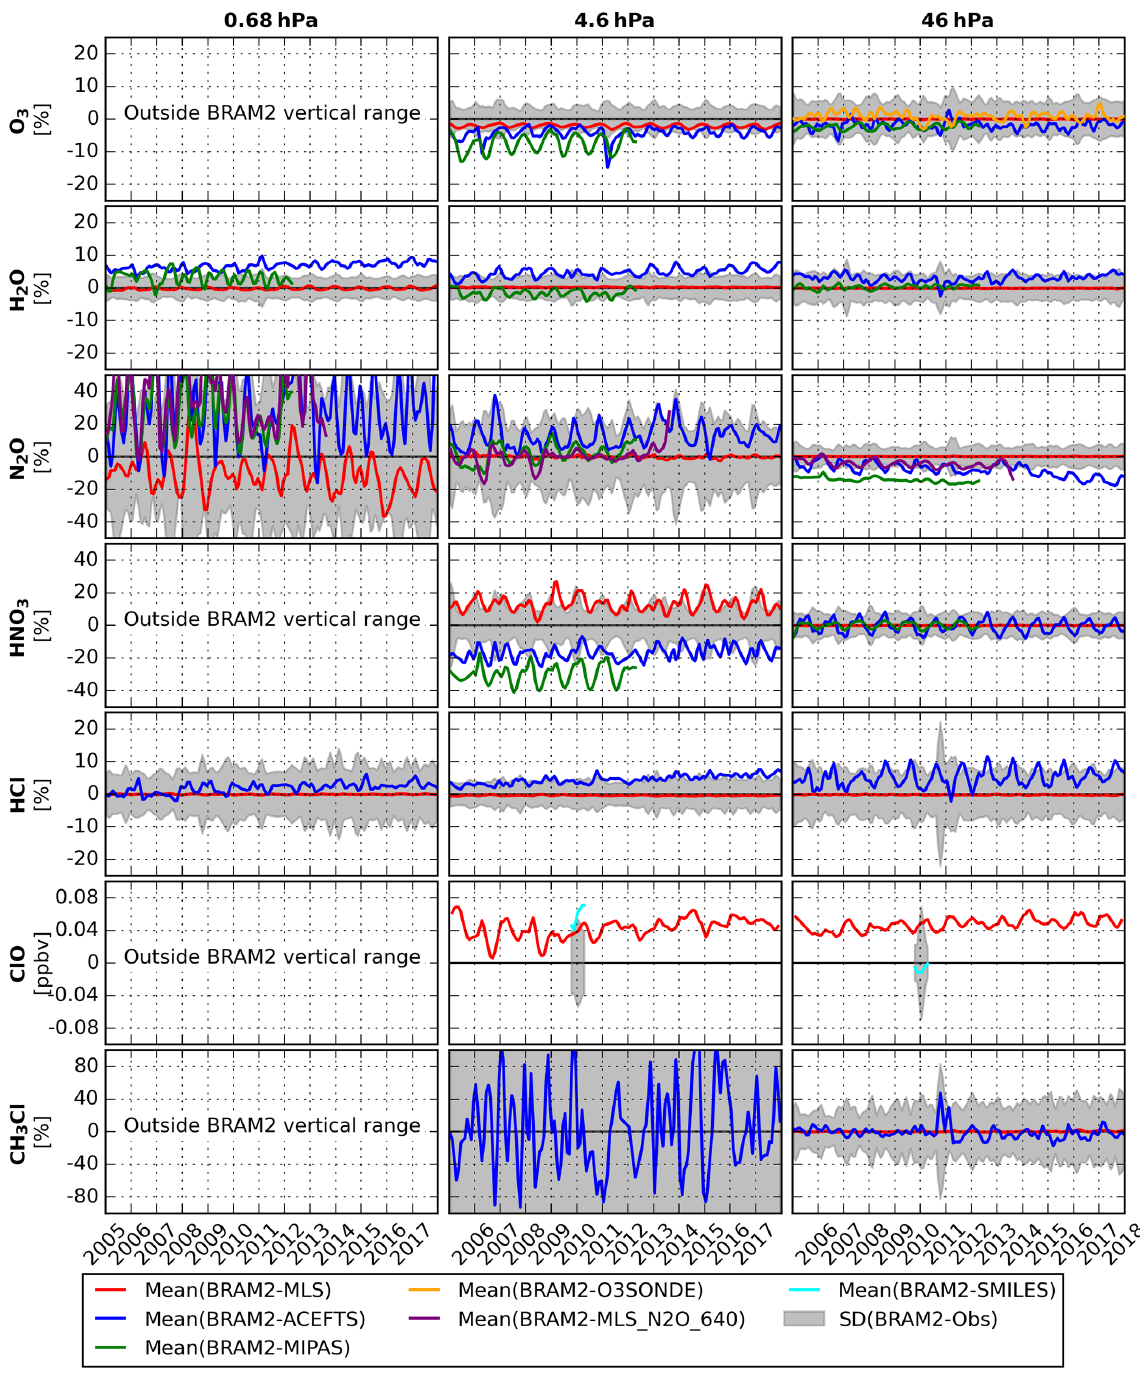
Figure 6. Time series of the monthly mean differences between BRAM2 and the different observational datasets in the Northern Hemisphere mid-latitudes (30–60 ◦ N) at three pressure levels (from left to right: 0.68, 4.6 and 46hPa) and for (top to bottom) O 3 , H 2 O, N 2 O, HNO 3 , HCl, daytime ClO and CH 3 Cl. Values are in percent except for ClO, which is shown in parts per billion by volume. The grey shaded area represents the standard deviation of the differences between BRAM2 and ACE-FTS except for ClO, where SMILES data are used.